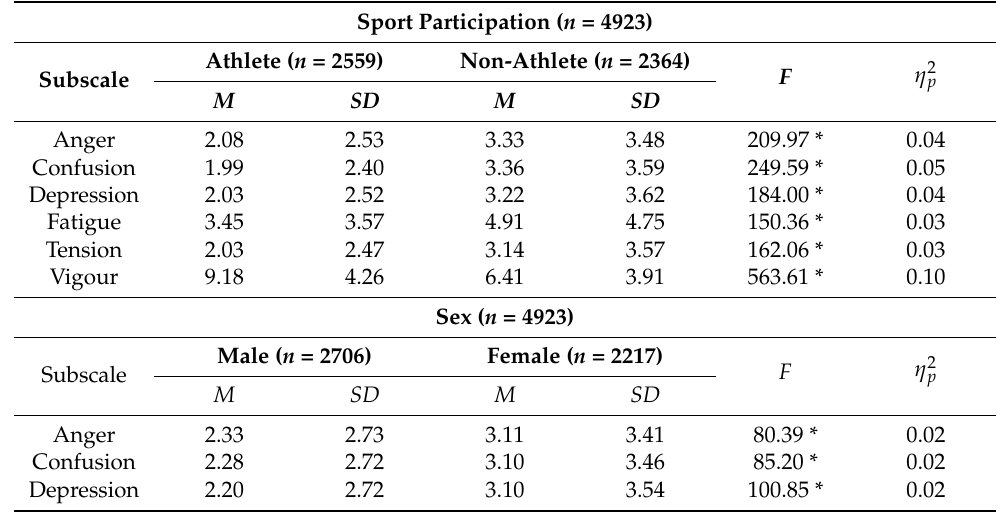
Table 10. MANOVAs of MASMS subscale scores by sport participation, sex, and age